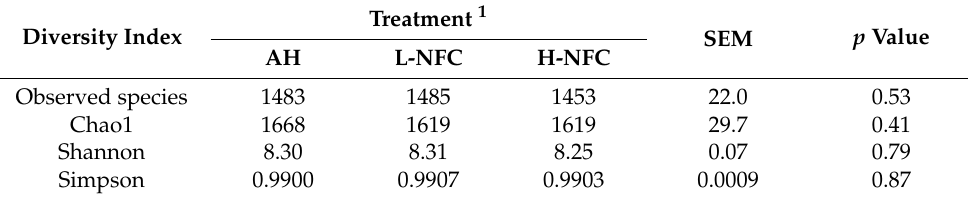
Table 1. Alpha diversity of the bacterial community in the rumen of dairy cows exposed to three different